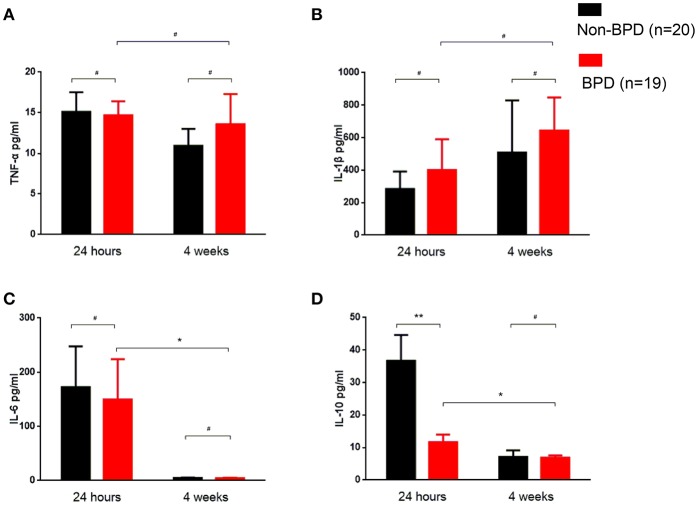
Inflammatory cytokine profiles of the BPD patients. Venous blood samples were taken at the indicated time, and cytokines were quantified using ELISA. (A) TNF-α was similar in 24-h and 4 weeks samples between BPD and non-BPD neonates. (B) IL-1β was almost invariable in the samples at different time points from BPD and non-BPD controls. (C) IL-6 was comparable in the 24-h samples or 4 weeks samples from BPD or non-BPD controls. Compared to the 24-h samples, the IL-6 level was significantly decreased in the 4 weeks samples of BPD patients (p = 0.0493). (D) IL-10 was significantly decreased in the 24-h samples from preterm infants with BPD (p = 0.0054). As observed in IL-6, IL-10 was further significantly decreased after 4 weeks of therapy (p = 0.0346). Twenty non-BPD patients and 19 BPD patients were included in the final study. #p > 0.05; *p < 0.05; **p < 0.01.